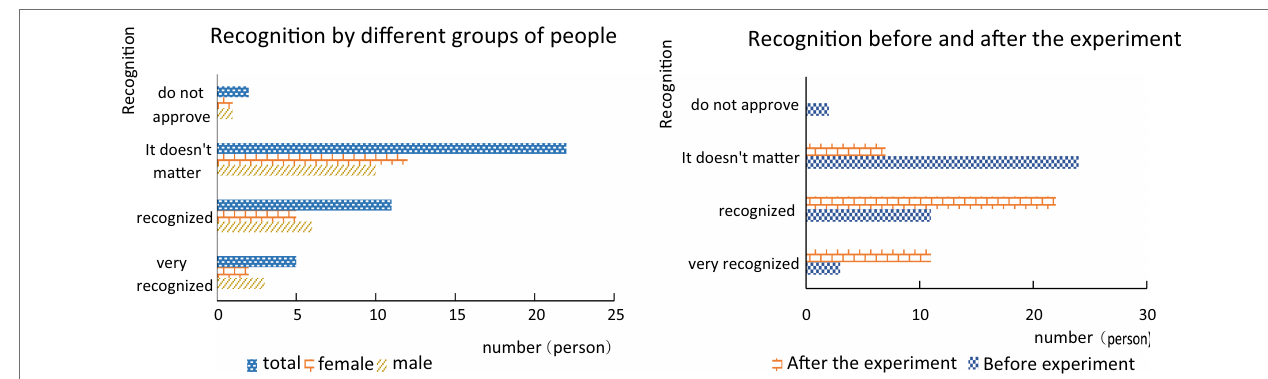
FIGURE 9 | Research report on students’ recognition of interactive teaching.